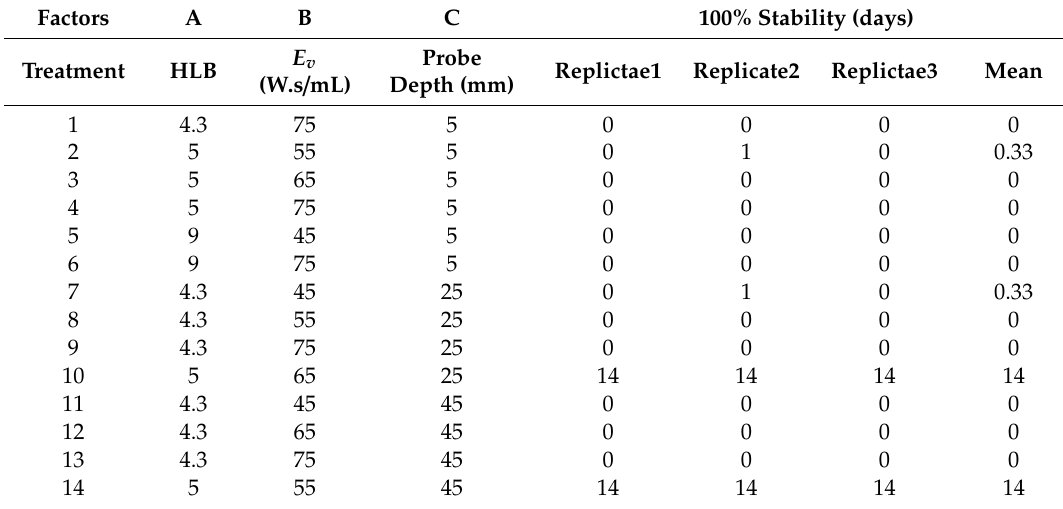
Table 8. 100% stability time (days) for the 14 emulsions for three-replicate